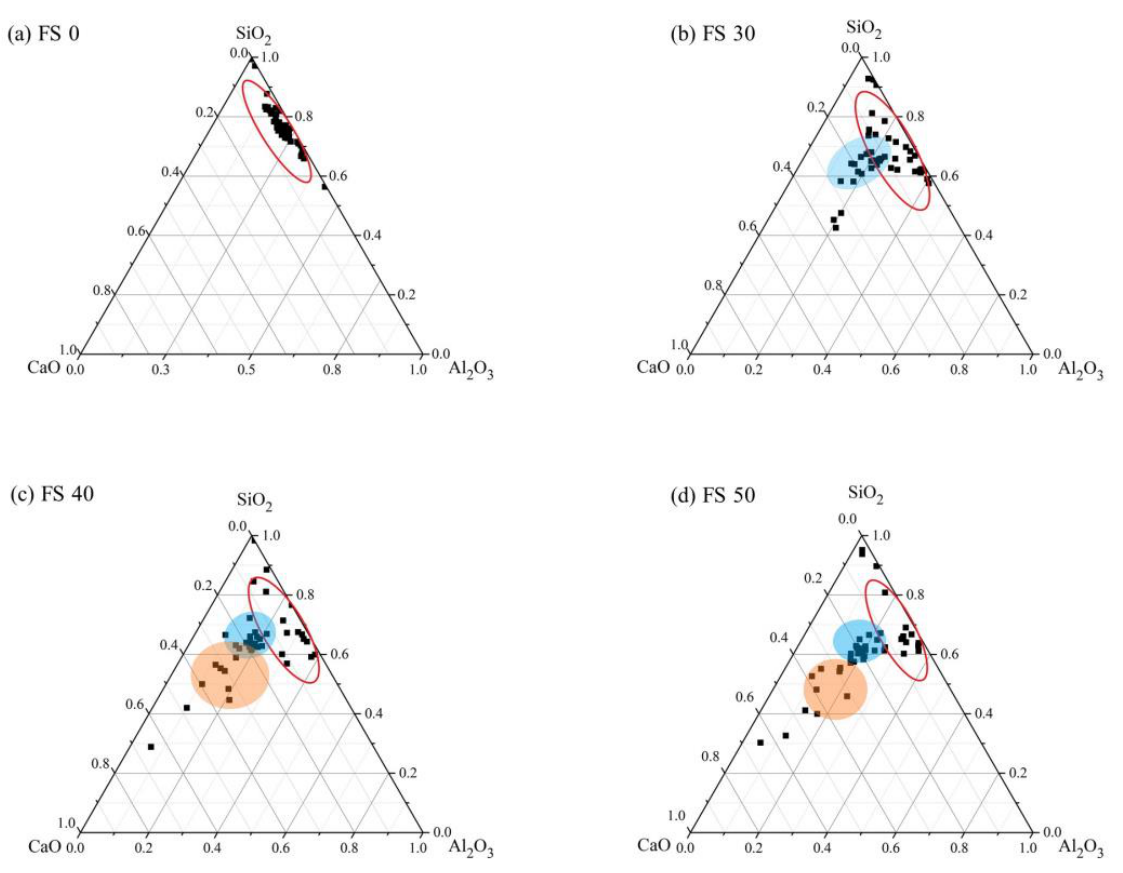
Figure 19. Ternary representation of EDS data for AAB with Ms of 1.4 exposed to ambient temper- ature.